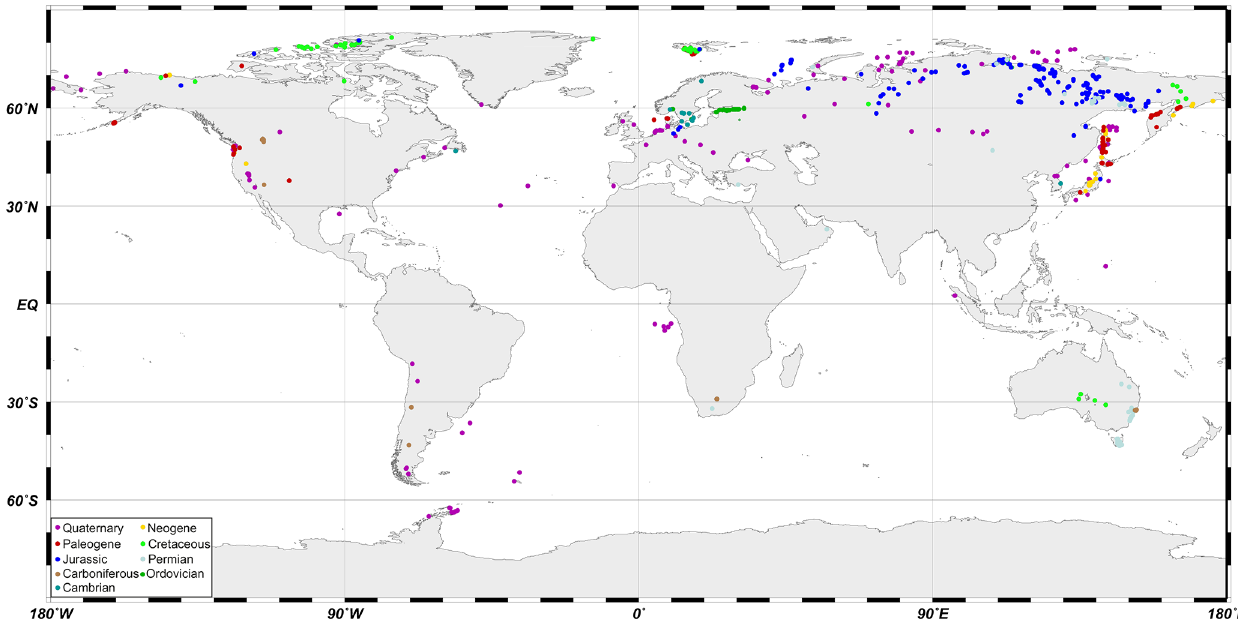
Figure 4. Map showing location of all ikaite and glendonite occurrences included to the database (prepared through Ocean Data View, Schlitzer,